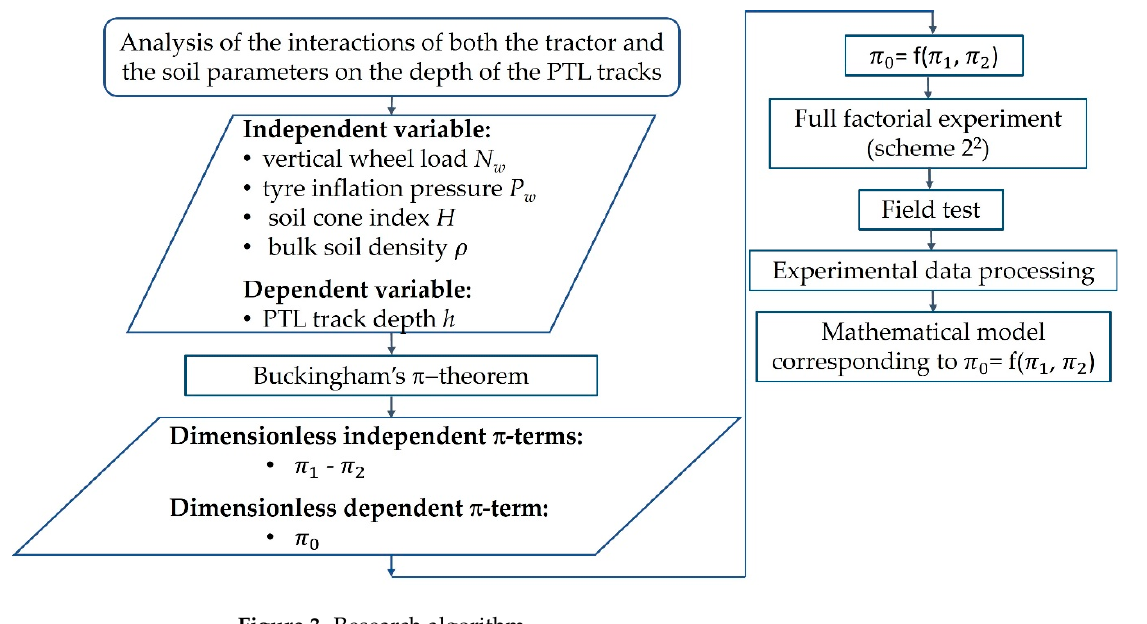
Figure 3. Research algorithm.